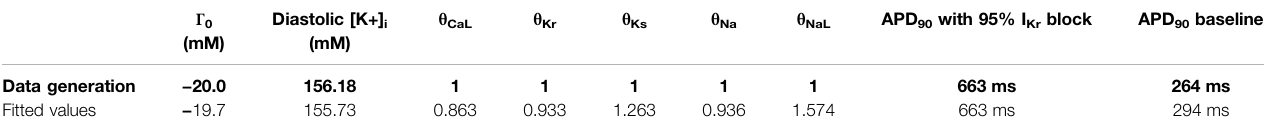
TABLE4| Rescalingfactorsforconductanceparametersretrievedfrom fi ttingtodatageneratedunderconditionswhereseveralstablelimitcyclescoexistforthesamevalue of Γ 0 = − 20 mM.